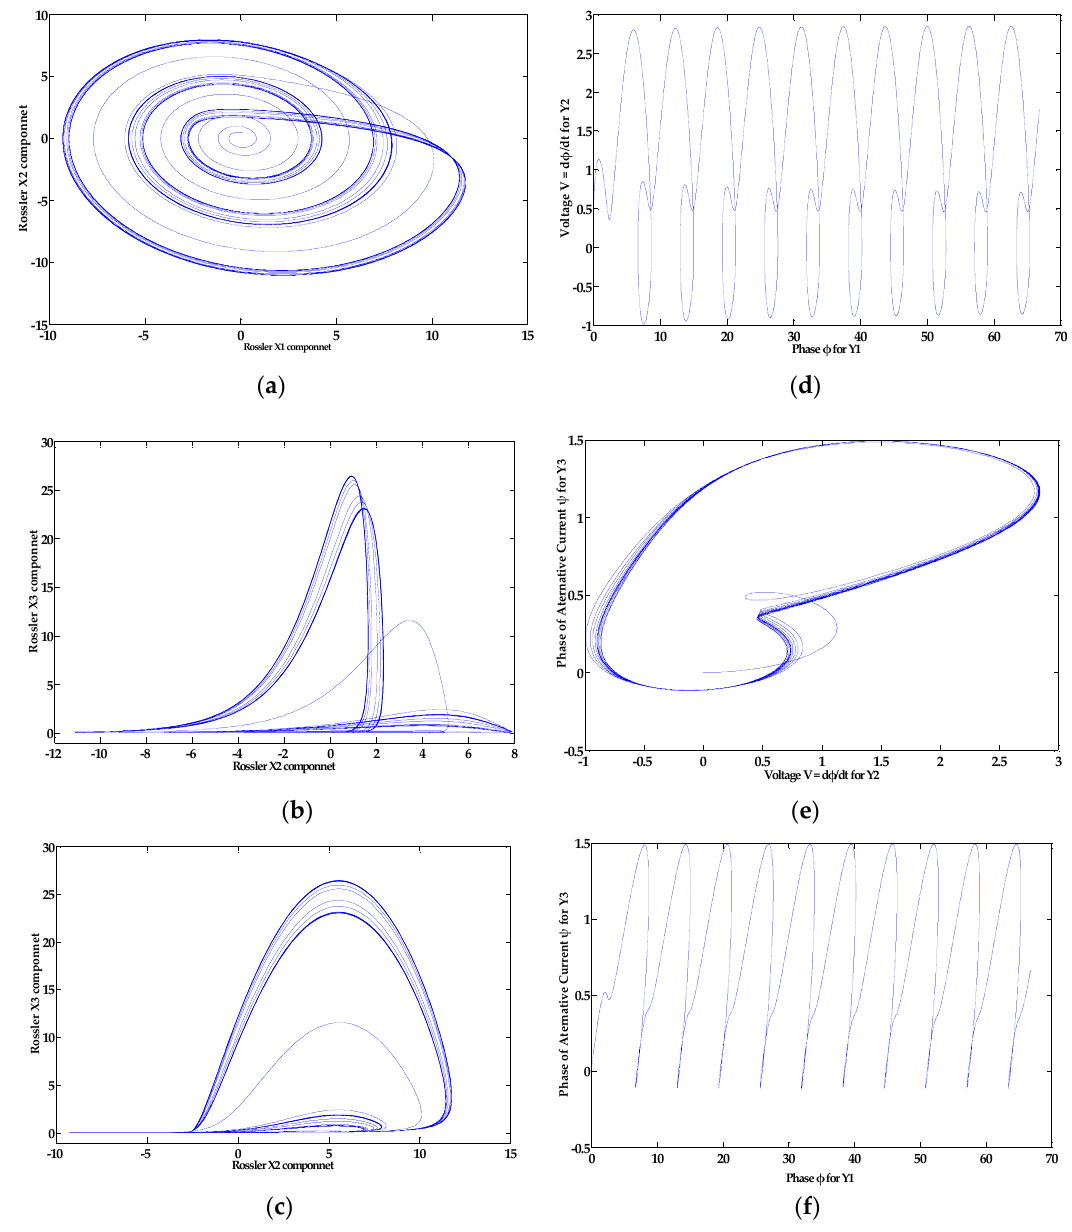
Figure 2. Original phase portrait of the Rossoler system with [ x 10 x 20 x 30 ] T = [ 0.2 0.4 0.1 ] T in the left column, ( a ) the Rossoler system x 1 , x 2 , ( b ) the Rossoler system x 2 , x 3 , and ( c ) the Rossoler system x 1 , x 3 , and the original phase portrait of the RCL-shunted Josephson Junction system with an initial condition at the original in the right column, ( d ) the RCLs-JJ system y 1 , y 2 , ( e ) the RCLs-JJ system y 2 , y 3 , and ( f ) the RCLs-JJ system y 1 , y 3